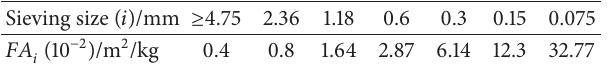
Table 5: Specific surface area coefficients for different sieving